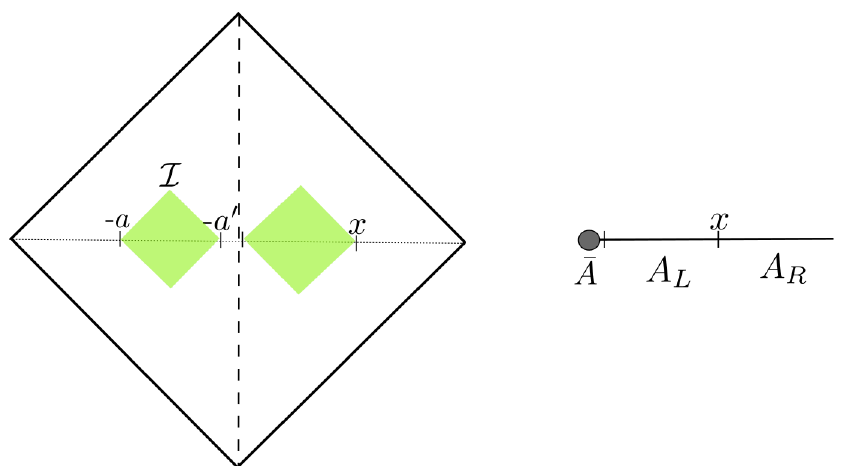
Figure 5: Left: Poincaré patch of AdS green diamonds are the domains of dependence of A holographic dual, a CFT on a half-line, with A need in order to compute the entanglement contour s